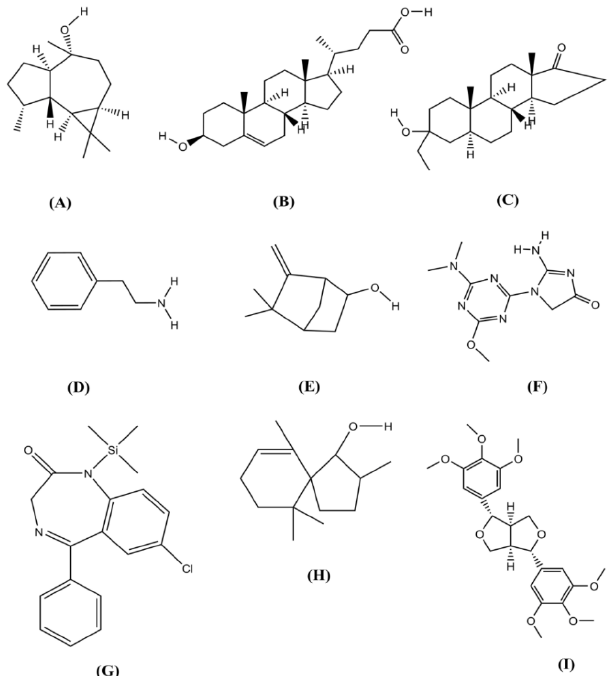
Figure 2. Chemical structure of ( A ) ( − )-Globulol; ( B ) 3.beta-Hydroxy-5-cholen-24-oic acid; ( C ) Androstan-17-one, 3-ethyl-3-hydroxy-, 5; ( D ) Benzeneethanamine; ( E ) Camphenol; ( F ) Imidazolidin-4-one, 2-imino-1-(4-methoxy-6-dimethylamino-1,3,5-triazin-2-yl); ( G ) Nordazepam, TMS derivative; ( H ) Spiro[4,5]dec-6-en-1-ol, 2,6,10,10-tetramethyl; ( I ) Yangambin (structures are drawn using ChemDraw Professional version 16). Molecules 2020 , 25 , x FOR PEER REVIEW Table 3. Molecular docking study of major bioactive compounds of methanol extract of T. crispa.